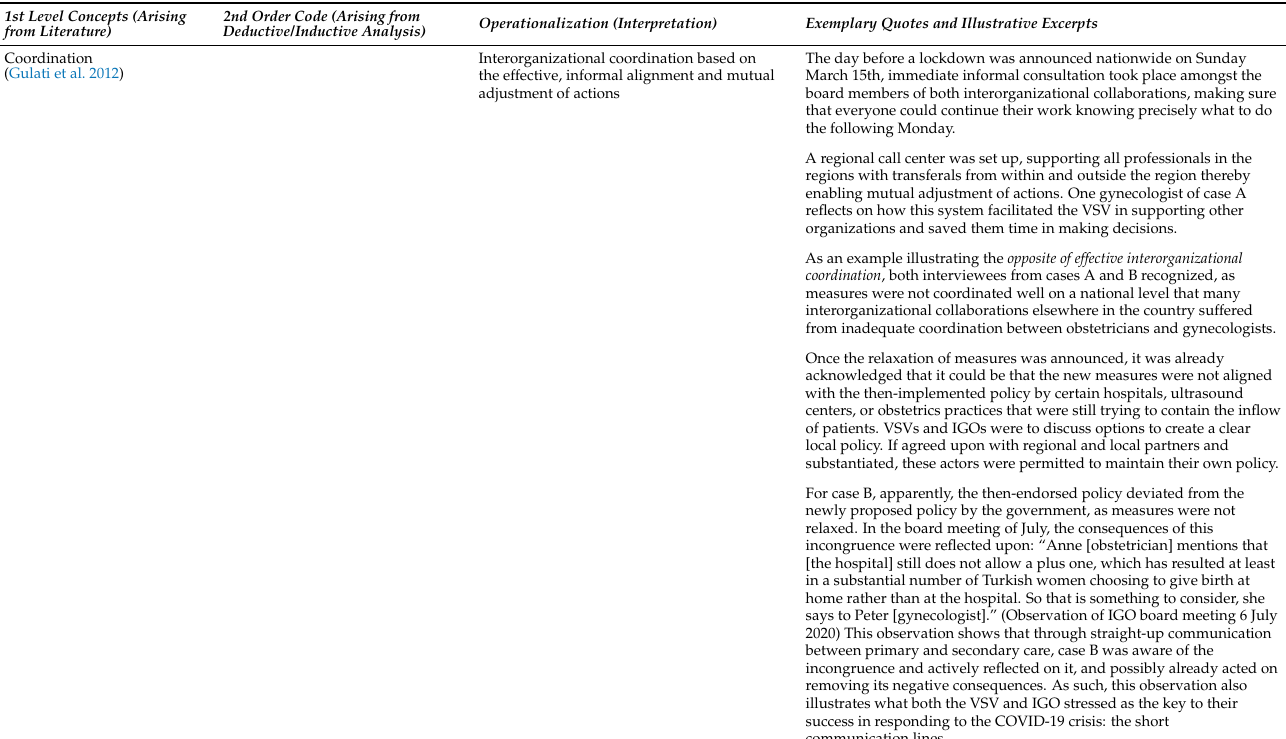
Table A2. Coding